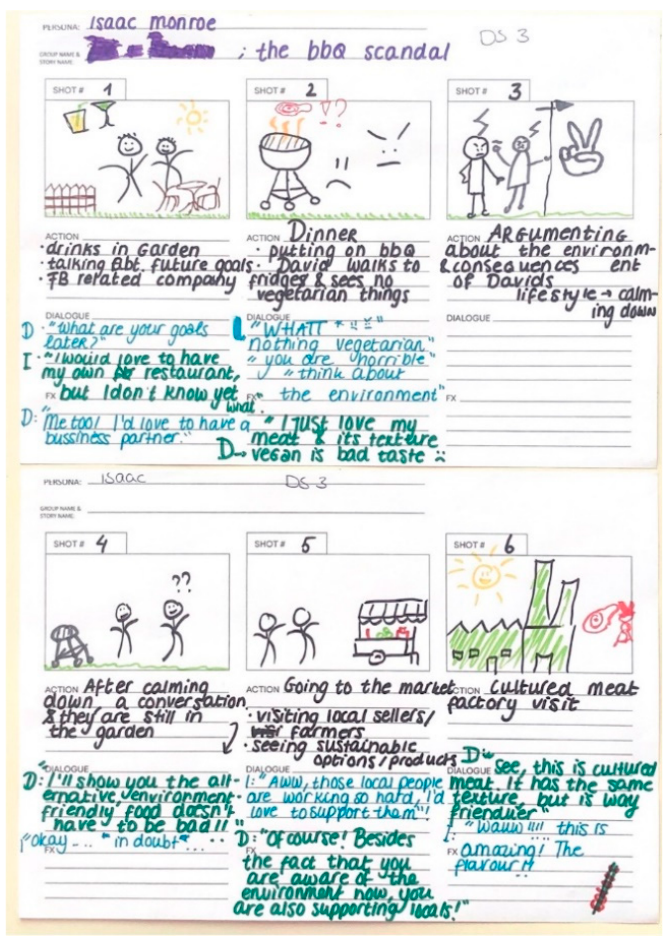
Figure 2. Illustration of the resulting consumer narrative using a